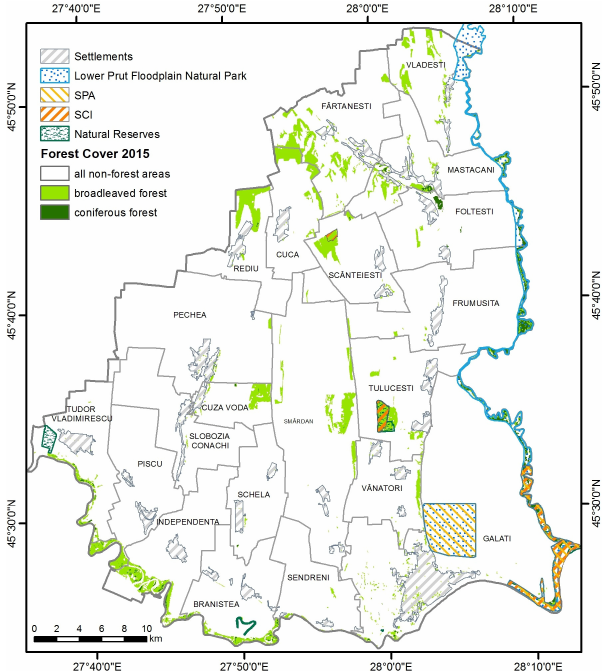
Figure 15. Natural protected areas and forest structure in Gala ţ i urban and peri-urban area.